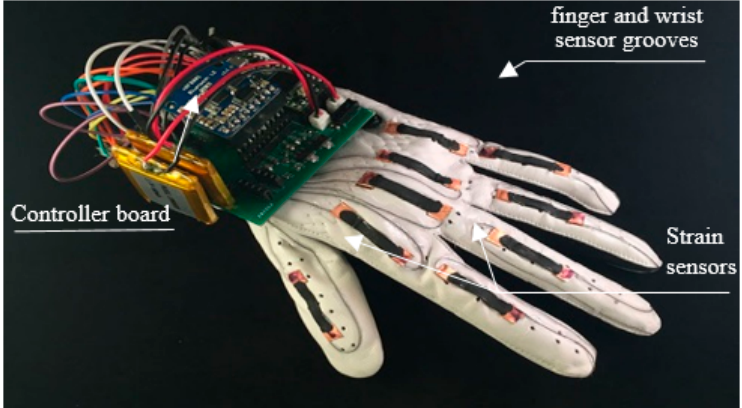
Figure 3. Sensor-based data glove (adapted from website: https://physicsworld.com/a/smart -glove- translates-sign-language-into-digital-text/).